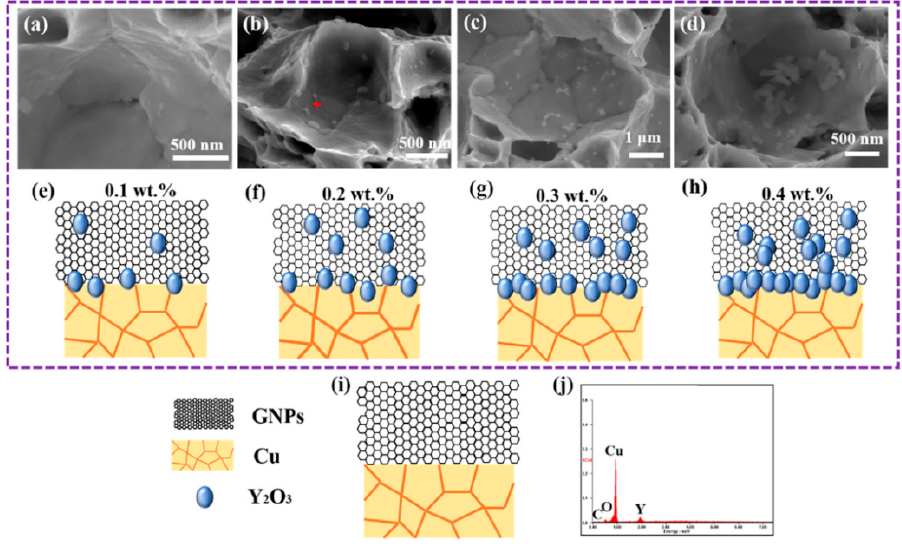
Figure 3. SEM images and schematics of fracture of GNP/Cu composites with different Y element content: ( a – d ) SEM images of fracture of 0.1 wt.% Y, 0.2 wt.% Y, 0.3 wt.% Y and 0.4 wt.% Y, respectively; ( e – i ) Schematic illustration of dispersion of Y 2 O 3 NPs in 0.1 wt.% Y, 0.2 wt.% Y, 0.3 wt.% Y 0.4 wt.% Y and GNP/Cu composites, respectively; ( j ) Representative energy spectrum of NPs lied at the fracture [16]. Reprinted/adapted with permission from Ref. [16]. Copyright year 2020,